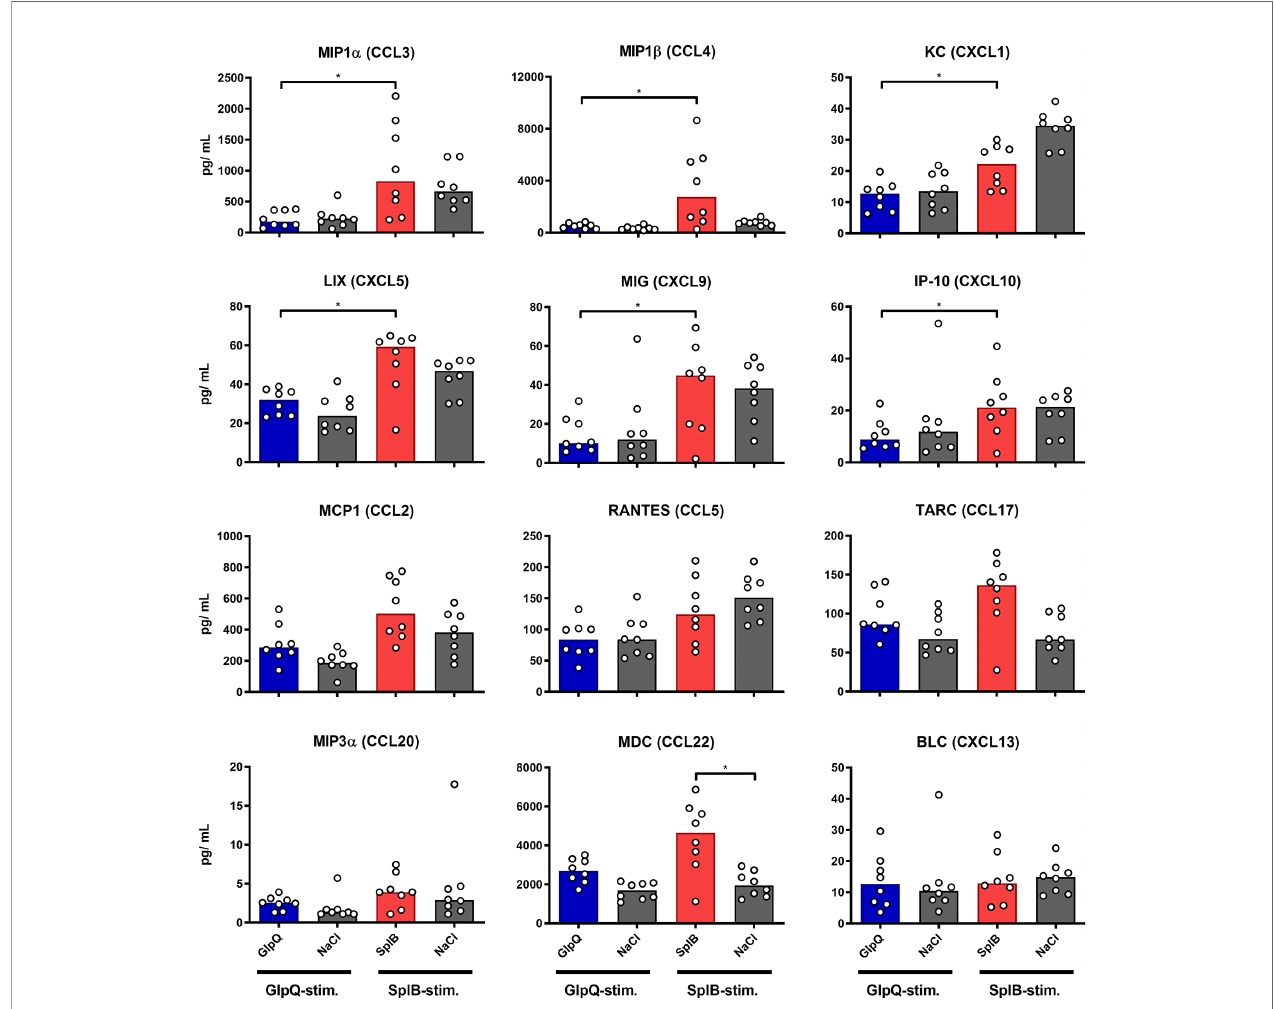
FIGURE 5 | SplB provoked a stronger production of proin fl ammatory chemokines than GlpQ. Isolated splenocytes were restimulated with the indicated vaccine antigen for 4 days, afterward the supernatant was harvested and the concentration of produced chemokines was measured via the LEGENDplex ™ Mouse Proin fl ammatory Chemokine Panel (13-plex). Data are presented as median. n = 8 animals per group. *p < 0.05. Group comparisons that are de fi ned in the “ Statistical analysis ” section but not shown here are not signi fi